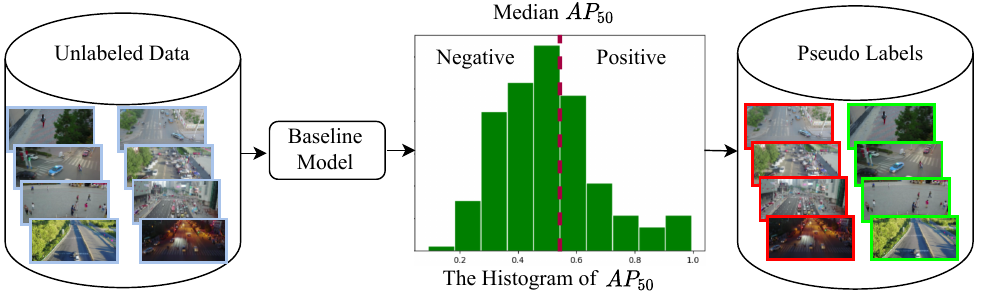
Figure 5. The pipeline of the pseudo label generation. Images with gray rectangles are fed into a pre-trained object detector. Images with an estimated precision higher than the threshold are treated as positive samples (shown with green rectangles) and images with an estimated precision lower than the threshold are treated as negative ones (shown with red